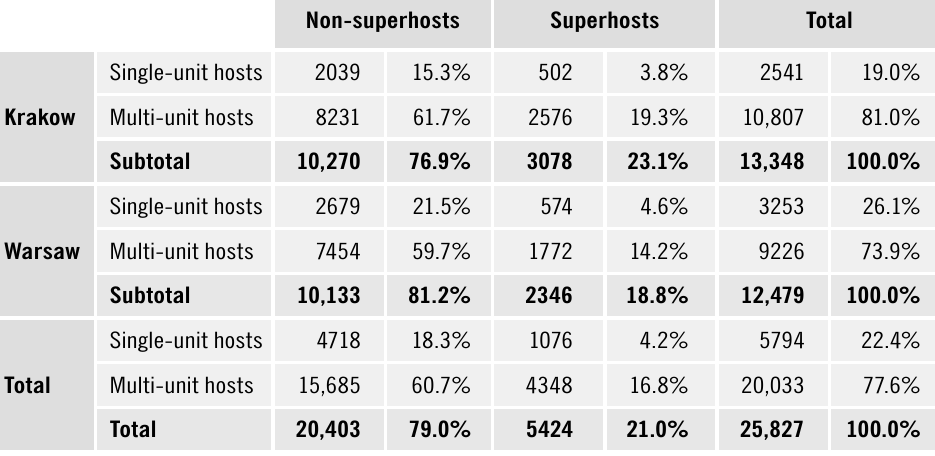
Table 3. Multi-unit host and superhost property characteristics by city Non-superhosts Superhosts